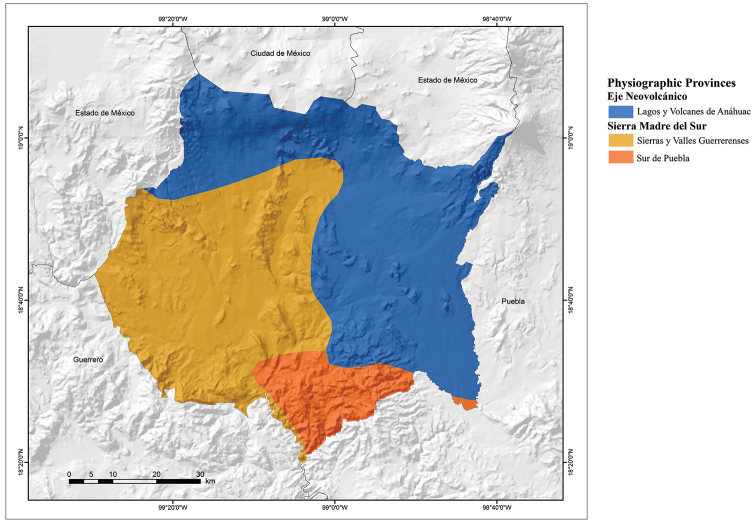
Physiographic provinces of the state of Morelos, Mexico (modified from Cervantes-Zamora et al. 1990).